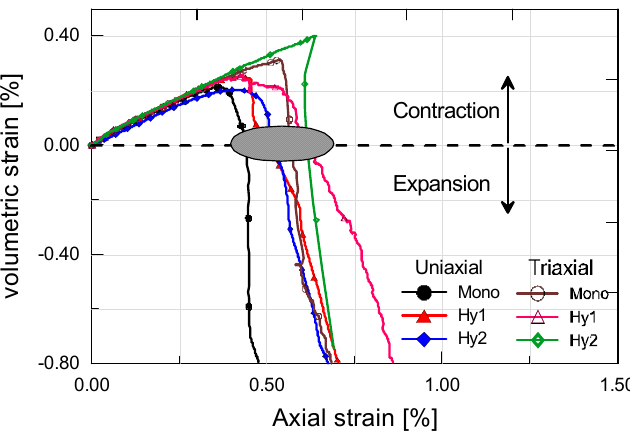
Figure 8. Volumetric strain-axial strain curves of different ECC mixtures under both axial and triaxial compression.